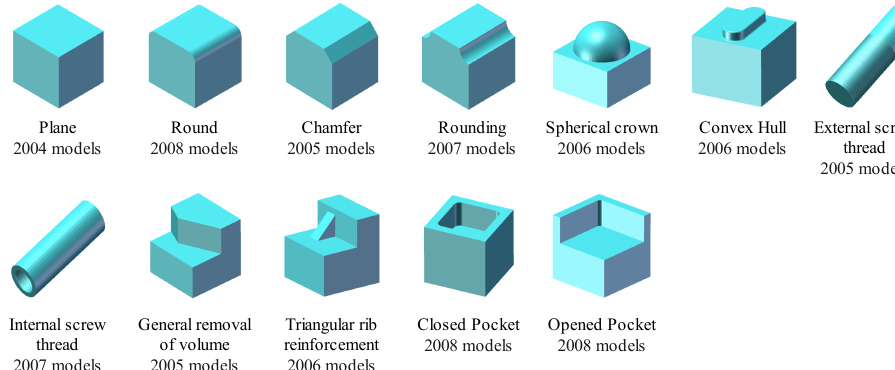
Figure A1. The overall machining features contained in MFDataset.